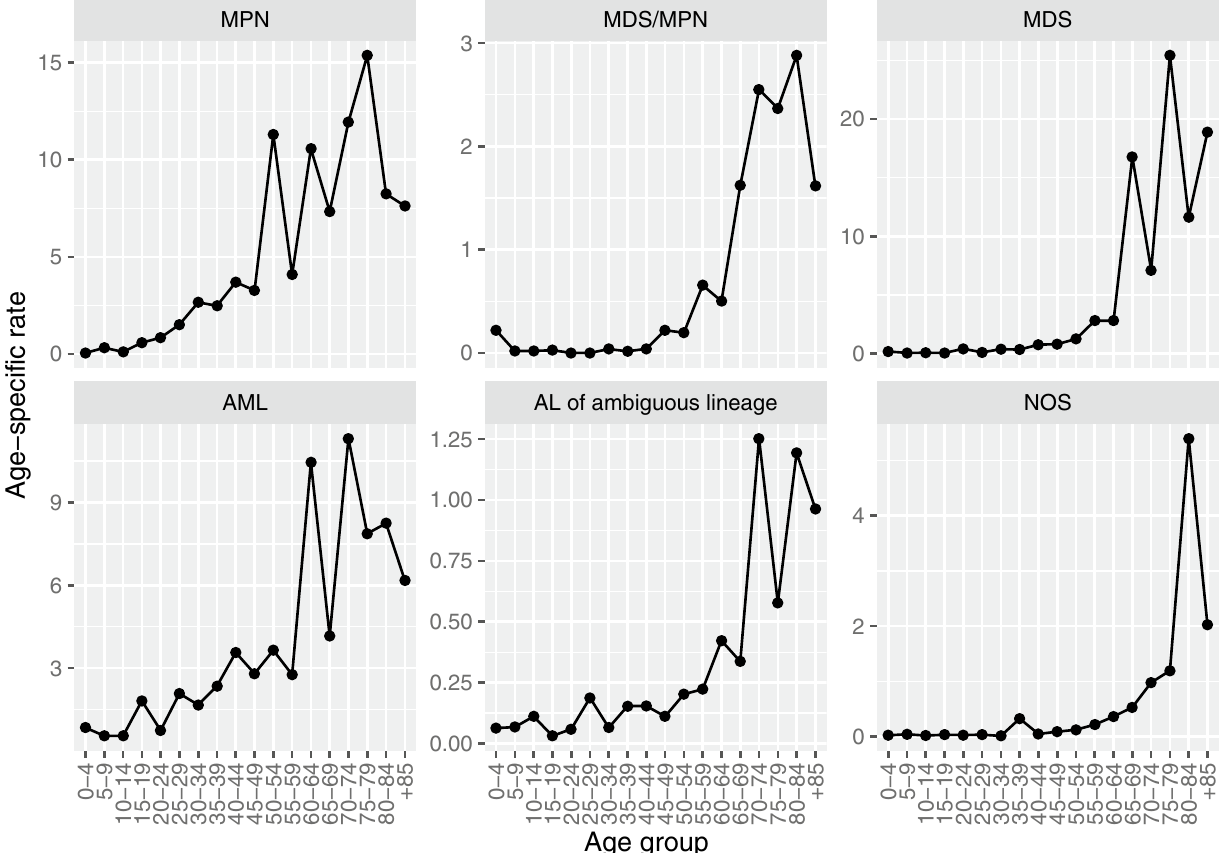
Figure 1. Age-specific incidence rates of broad categories of myeloid neoplasms diagnosed in Spain during 2002–2013. AML acute myeloid leukemia, AL acute leukemia, MDS myelodysplastic syndromes, MPN myeloproliferative neoplasms, NOS not-otherwise specified. Rates are expressed per 100,000